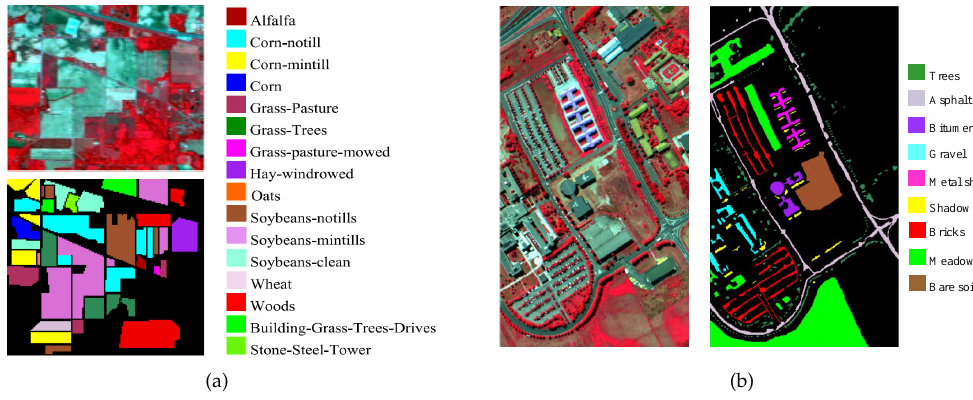
Figure 1. Sample image and corresponding ground truth map. ( a ) Indian Pines data set. ( b ) Pavia University data